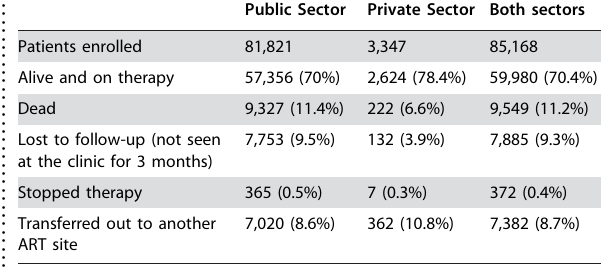
Table 1. National treatment outcomes of patients enrolled to antiretroviral therapy (ART) in the public sector, private sector and both sectors combined together, with